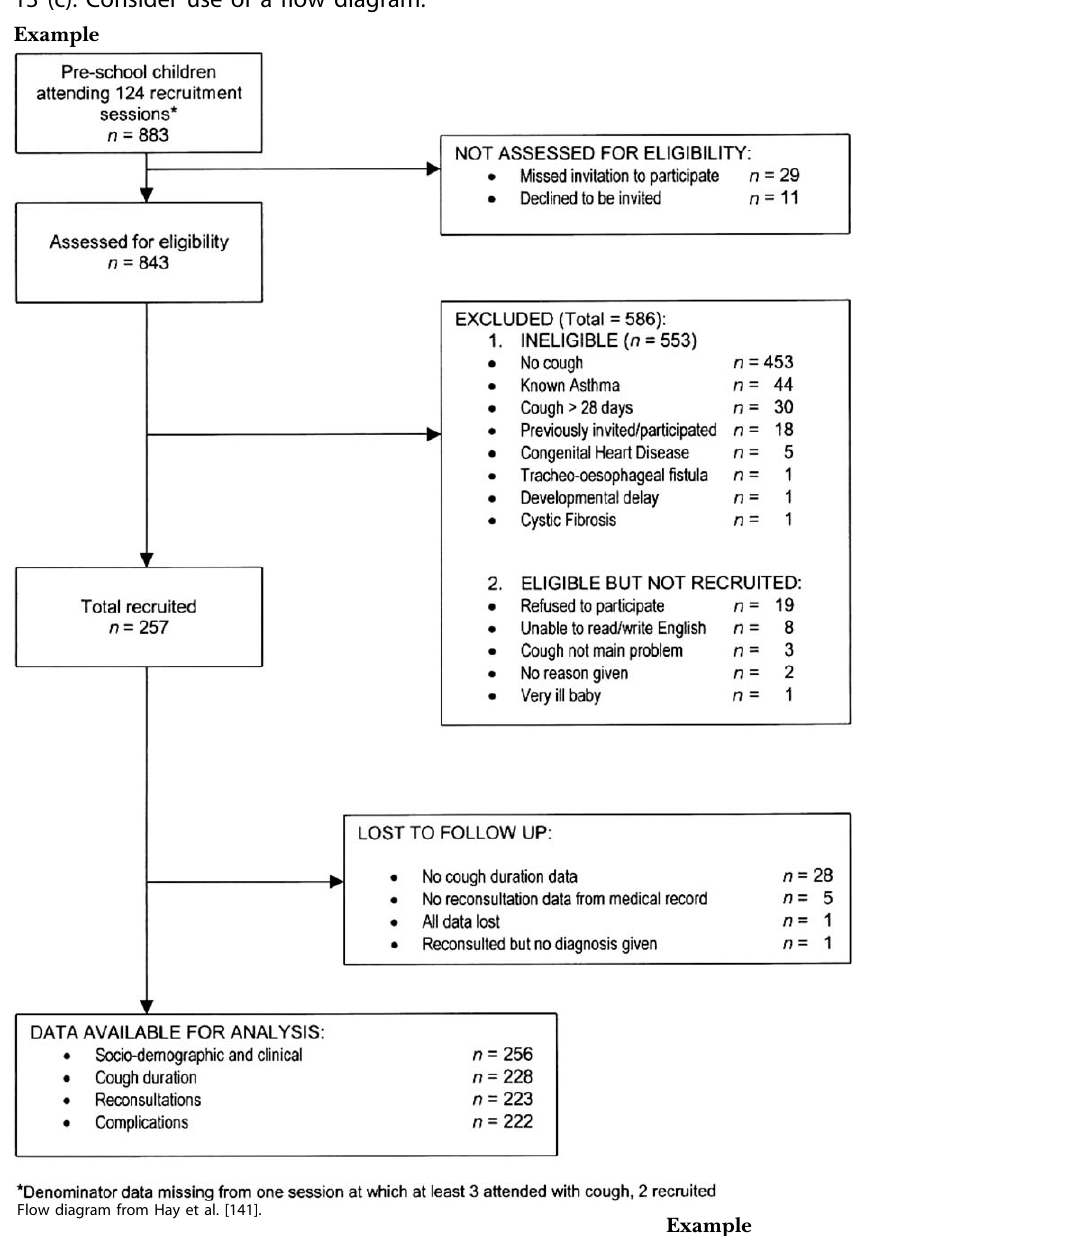
Table. Characteristics of the Study Base at Enrolment,